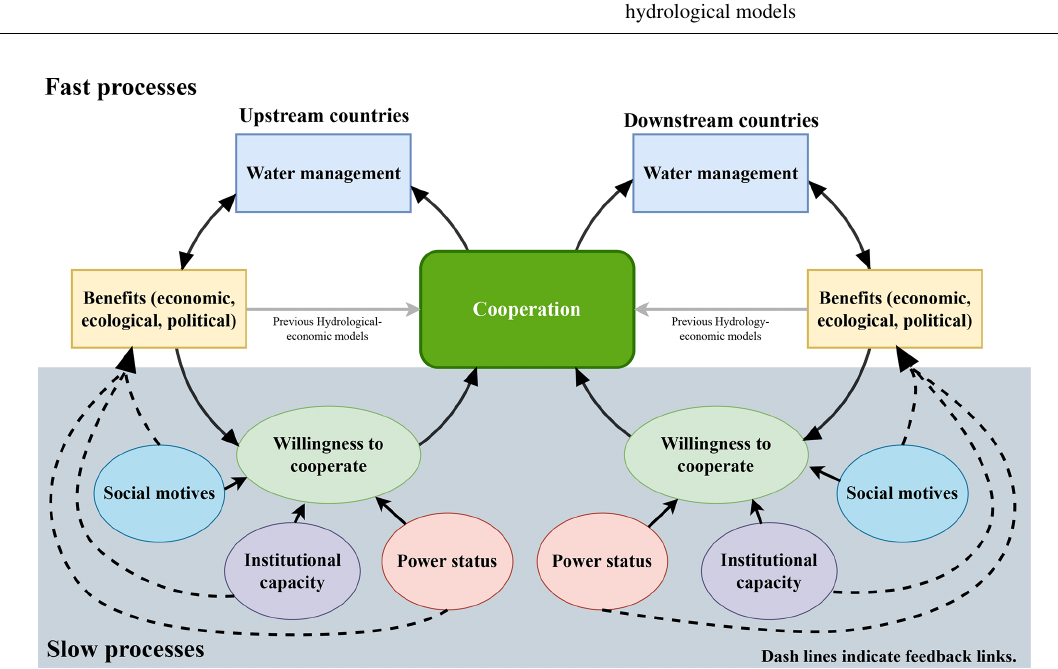
Figure 1. A socio-hydrological framework for understanding conflict and cooperation with respect to transboundary rivers.